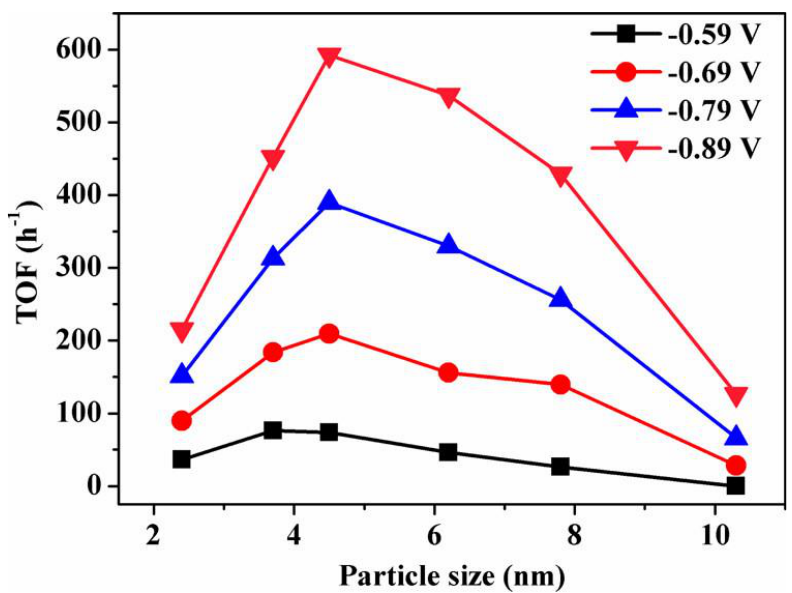
Figure 8. Applied potential dependence of ( a ) Faradaic efficiencies and ( b ) current densities for CO production over Pd NPs with different sizes. Reprinted from Ref. [113], copyright (2015), with per- mission from the American Chemical Society.